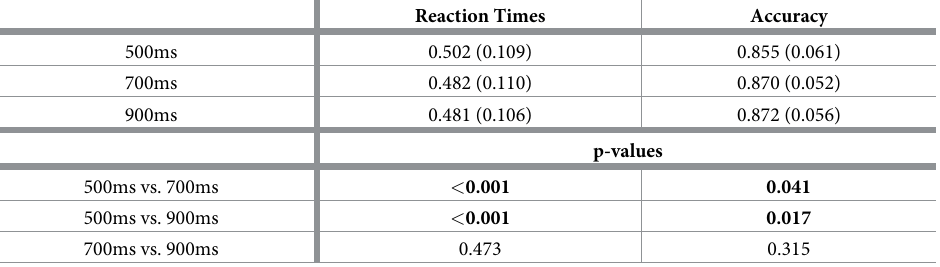
Table 1. Top half: RTs (in seconds) and accuracy (proportions of correct responses), with standard deviations, in the different SOA conditions, regardless of pre-stimulus type. Bottom half: p-values of pairwise comparisons (one-tail